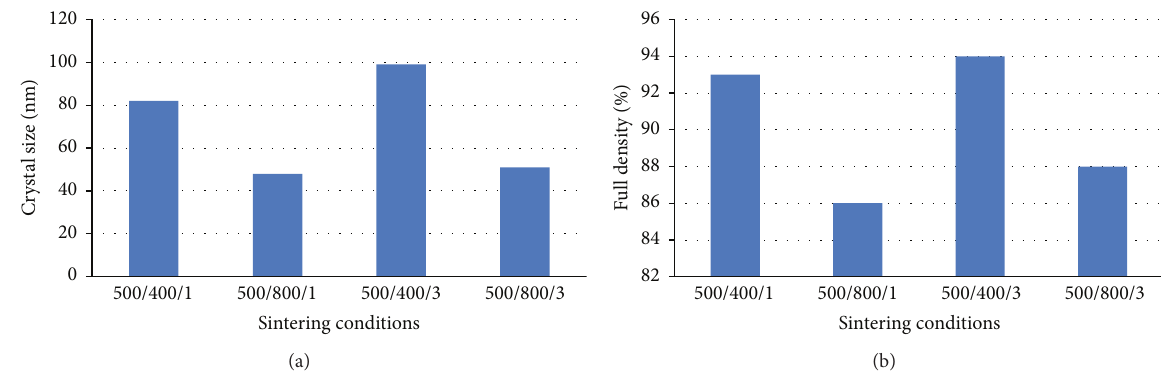
Figure 8: Effect of heating rate on crystal size in (a) and percentage of full density in (b) for the sintering temperature of 500 ∘ C and for two sintering times of 1 and 3 minutes.